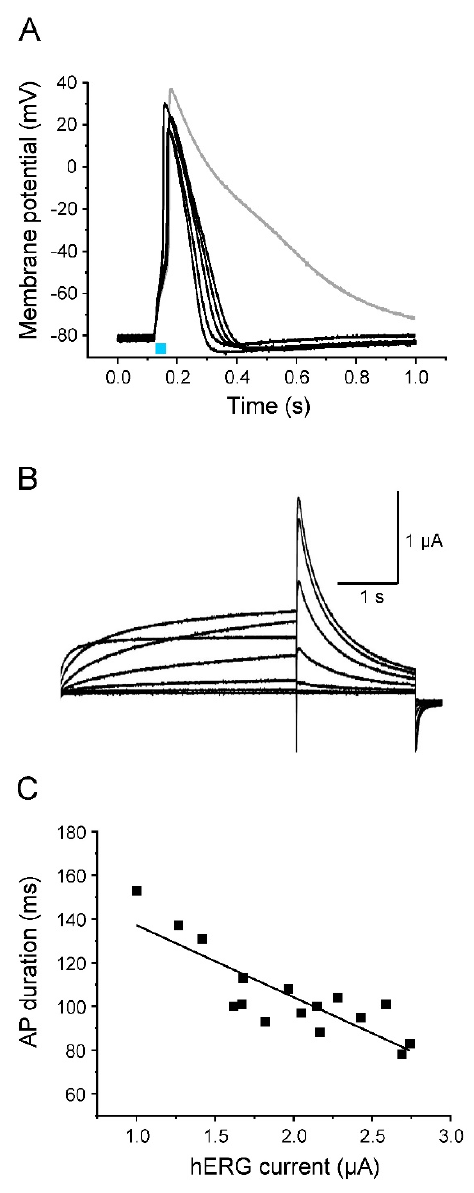
Figure 7. Acceleration of AP repolarization by hERG. ( A ) Representative light-induced APs from 5 different oocytes co-expressing Na v 1.5-CC-2 and hERG (light pulse 30 ms). The gray line represents a control AP from an oocyte injected with Na v 1.5-CC-2 cRNA only. For detailed statistics on AP parameters, peak current data, and oocyte features, see Table 3 and “Supplementary Materials” (Table S1). ( B ) Corresponding hERG currents elicited by prepulses between − 50 mV and +10 mV in 10 mV increments, followed by a second test pulse to − 50 mV (holding potential − 90 mV). ( C ) Correlation between AP duration, measured in the current-clamp mode at − 40 mV, and the corresponding hERG peak current at − 50 mV, recorded in the voltage-clamp mode (prepulse: +10 mV for 4 s; n = 16 from 5 different batches of oocytes). The line represents the results of a linear fit (y = − 32.92x + 170.05, R 2 = 0.71).